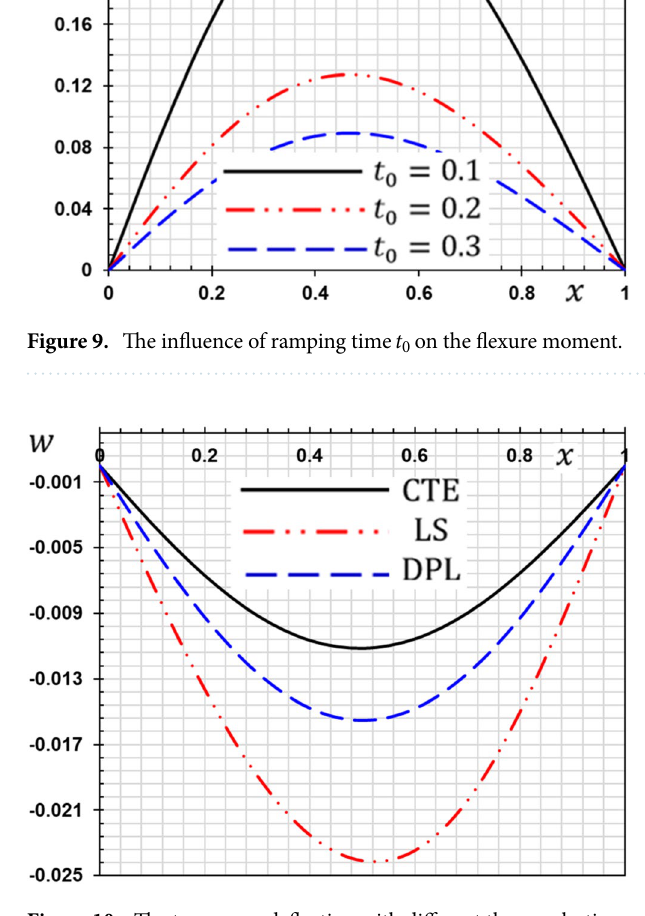
Figure 10. The transverse deflection with different thermoelastic models.